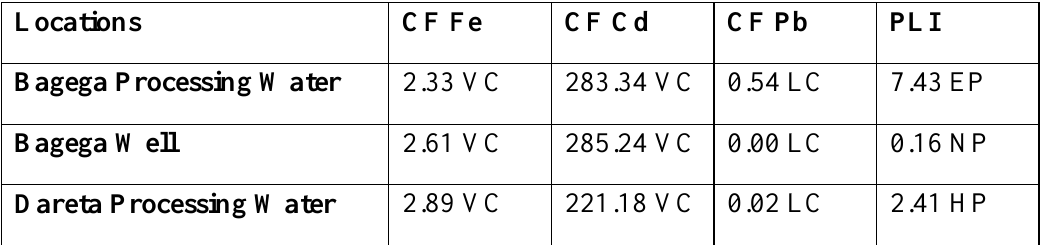
Table 3. Contamination factors and pollution load index of the heavy metals in water from all the study locations in Anka Local Government, Zamfara